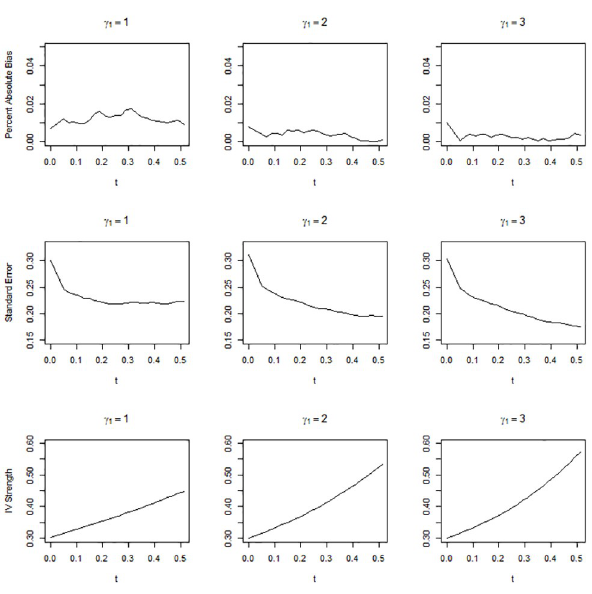
Fig 2. Absolute percentage bias, standard error, and IV strength for the local average treatment effect with a complier population size of 0.3. The X-axis indicates the percentile of the estimated compliance scores for the cutpoint t